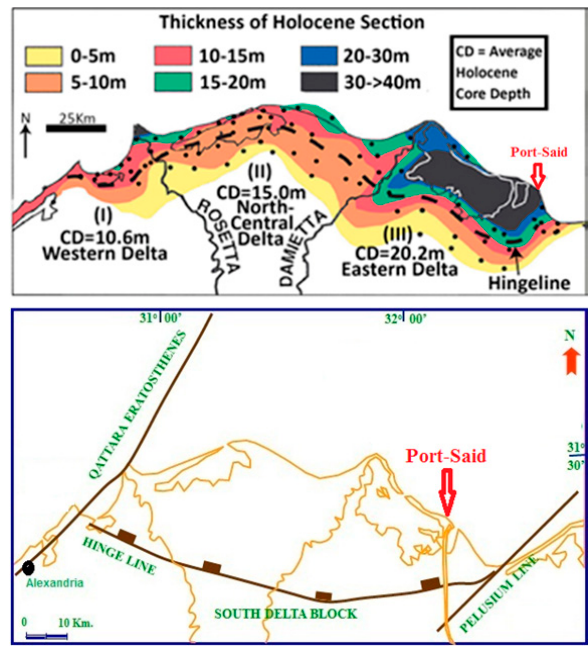
Figure 1. The top map shows the average thickness of Holocene sediments in the northern delta (modified after Stanley and Clemente, [26]) and the bottom map shows the regional structural setting of the northern Nile Delta (modified after Mosconi et al. [42]).